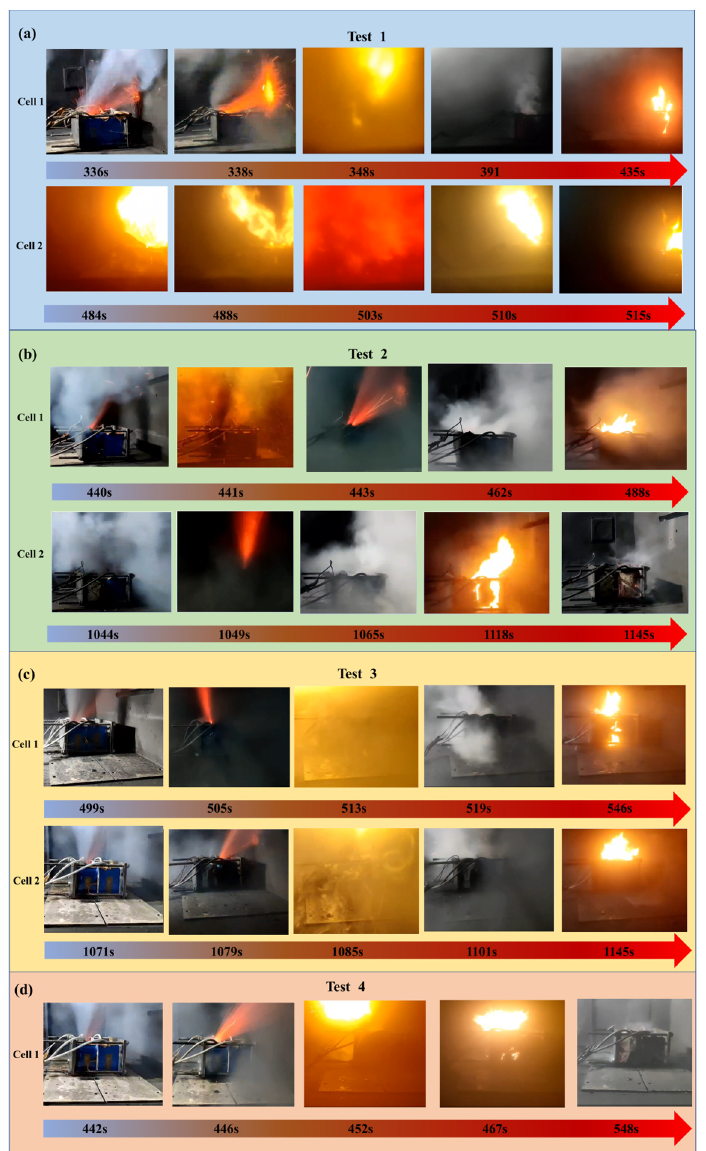
Figure 6. TR behavior of thermal barriers with different areas: ( a ) test 1; ( b ) test 2; ( c ) test 3; and ( d ) test 4.